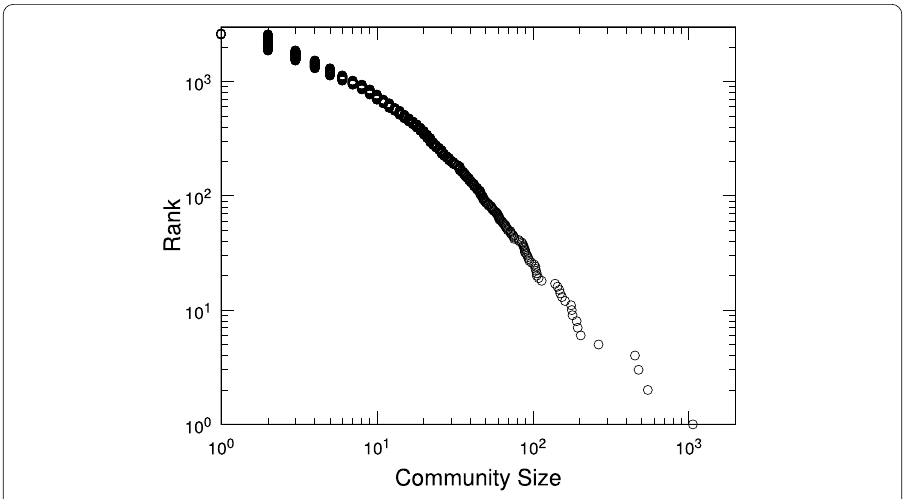
Figure 6 Distributions of the sizes of irreducible communities. Rank-size plot for the sizes of irreducible communities detected using the Infomap method at all the levels, where the ranks are in descending order of the size with the lowest rank equal to the total number of irreducible communities (see Table 3). The size of a community is simply the number of nodes included in the